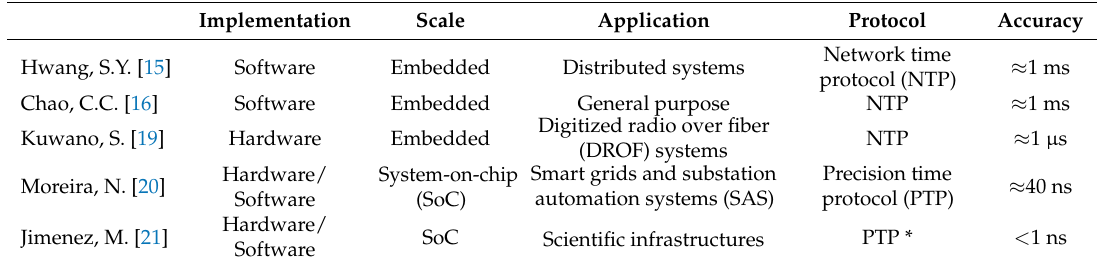
Table 1. Comparison of related